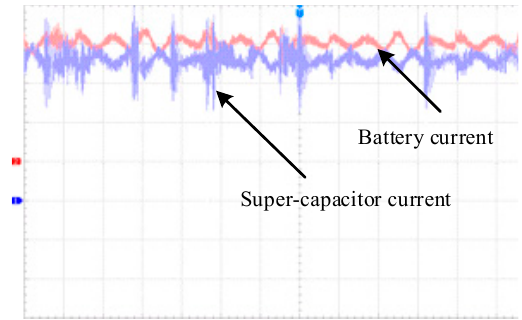
Figure 27. Battery and super-capacitor currents.